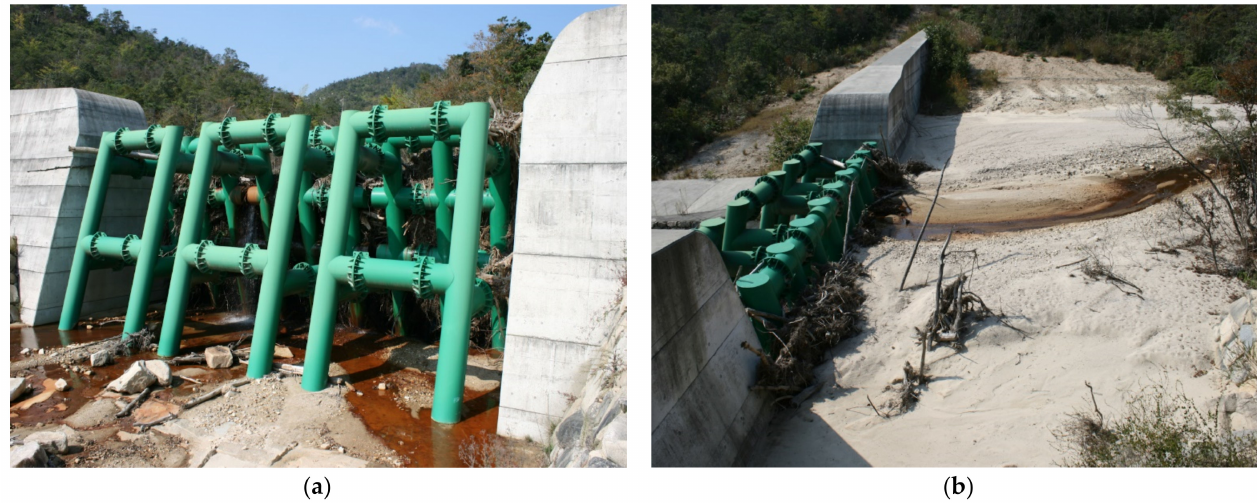
Figure 2. ( a ) LW captured by an open sabo dam (check dam) during heavy rainfall in Hofu City (Yamaguchi Prefecture) in 2009; ( b ) A large amount of sediment accumulated with the driftwood, completely clogging the check